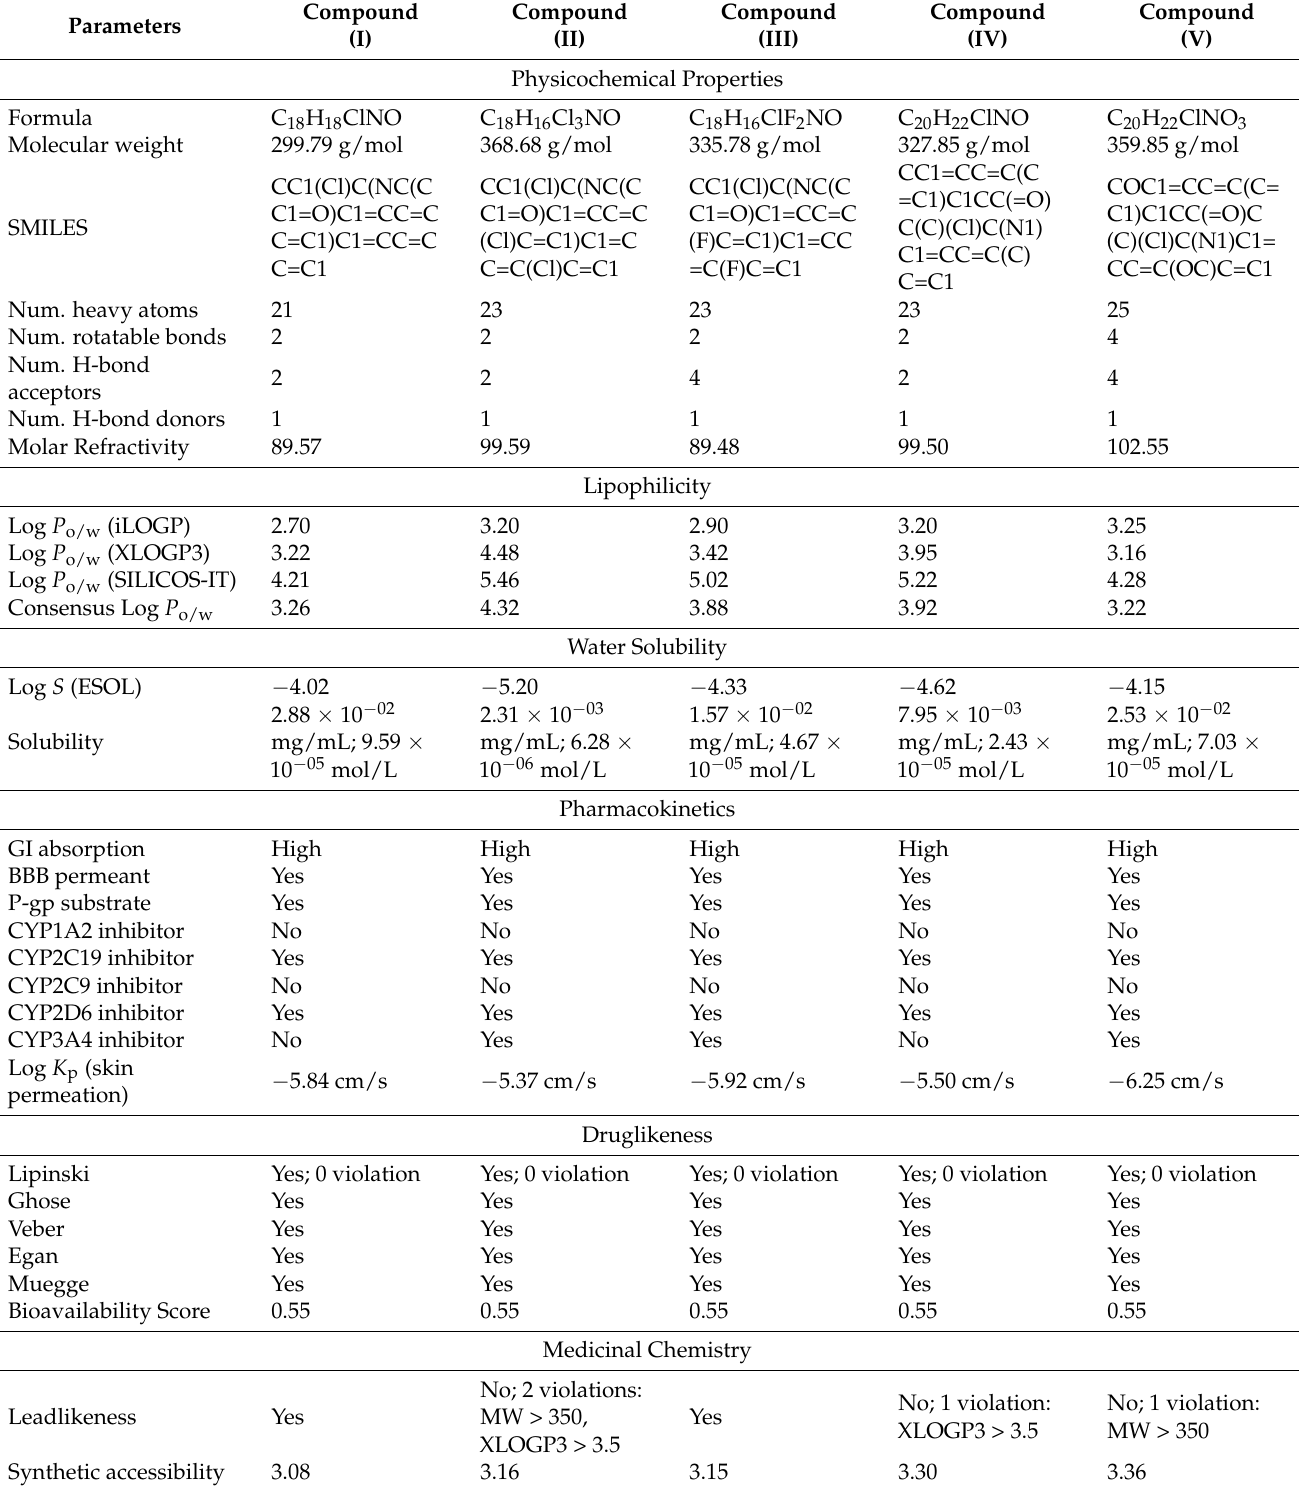
Table 2. Complete ADMET profile of compounds ( I – V ), including pharmacokinetics, physicochemical properties, lipophilicity, water-solubility, pharmacokinetics, drug-likeness, and medicinal